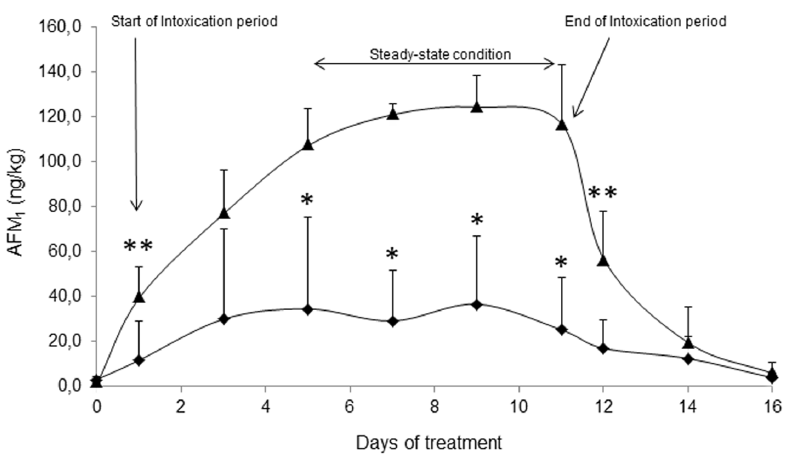
Figure 2. Average AFM 1 concentration in milk. Six vaccinated ( X ) and six unvaccinated control ( m ) cows were fed 102 m g of AFB 1 /day from day 1 to day 11. Data are presented as mean 6 SD. Within each day, differences between vaccinated and control cows are marked (**P , 0.10, *P ,